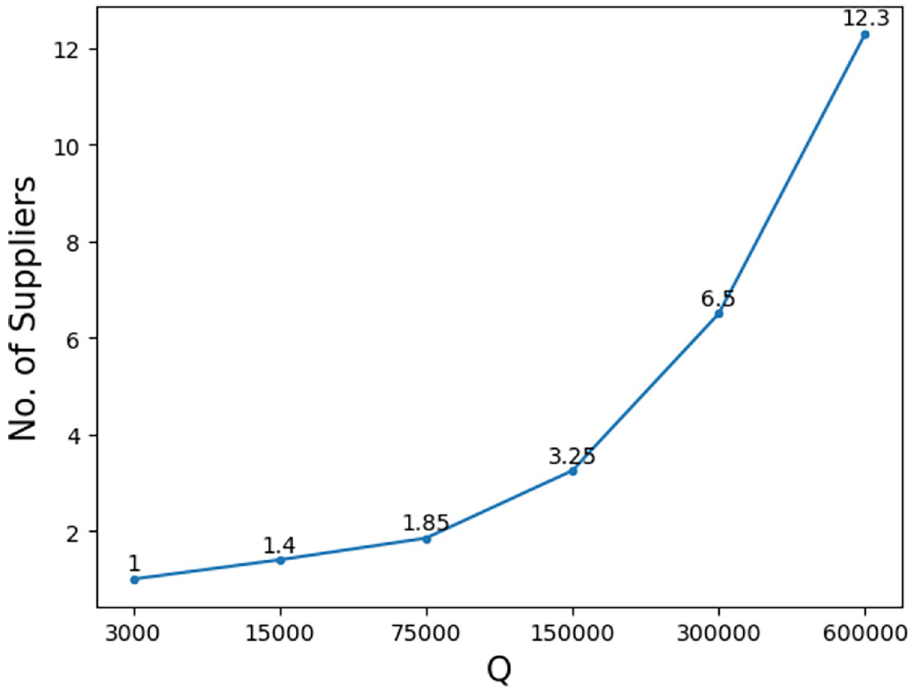
Fig 14. The average number of suppliers in the optimal solutions for different Q